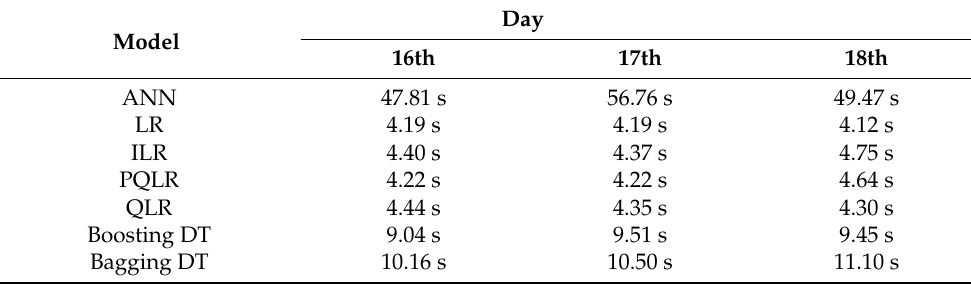
Table 13. Approximate computational times for different models.